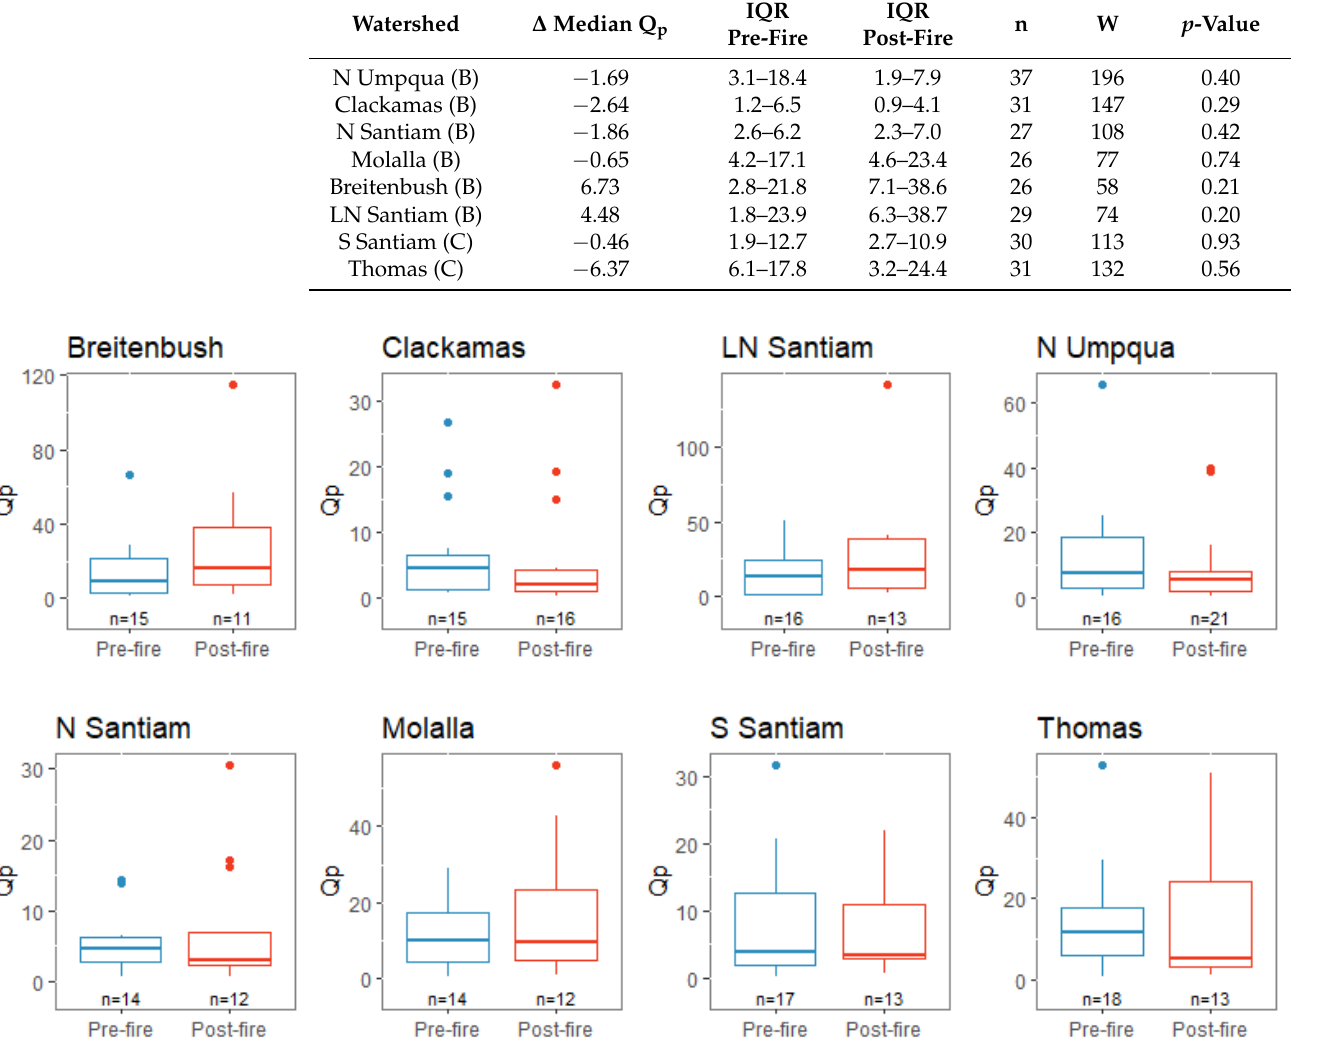
Table 5. Q p results of Mann–Whitney U test and change in median Q p values and interquartile range (IQR) of pre- and post-fire Q p values for six burned watersheds (B) and two controlled watersheds (C). The significance level was considered at a p value < 0.10.